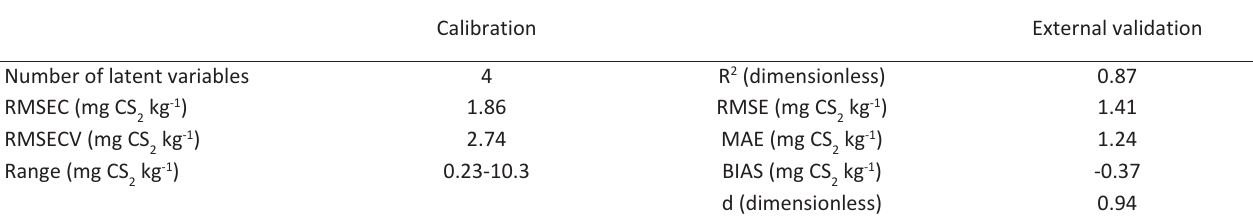
Table 1 ­ Statistical parameters of calibration with cross­validation and external validation processes for the estimation model of dithio­ carbamate concentration on